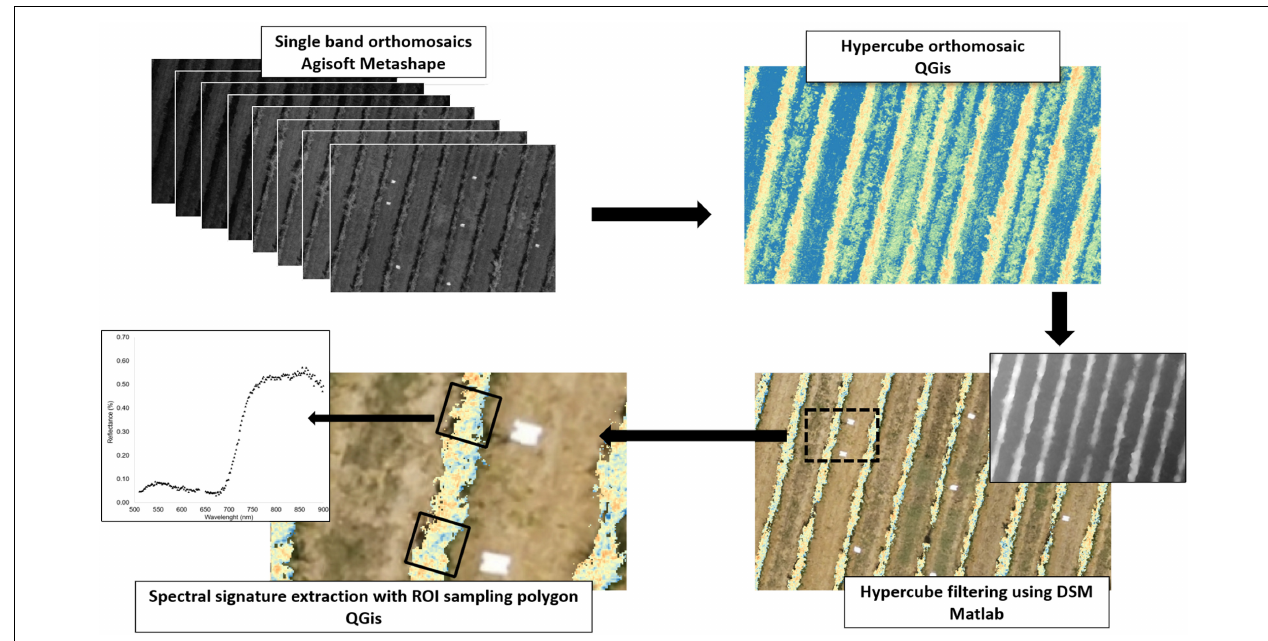
FIGURE 3 | Hyperspectral images processing